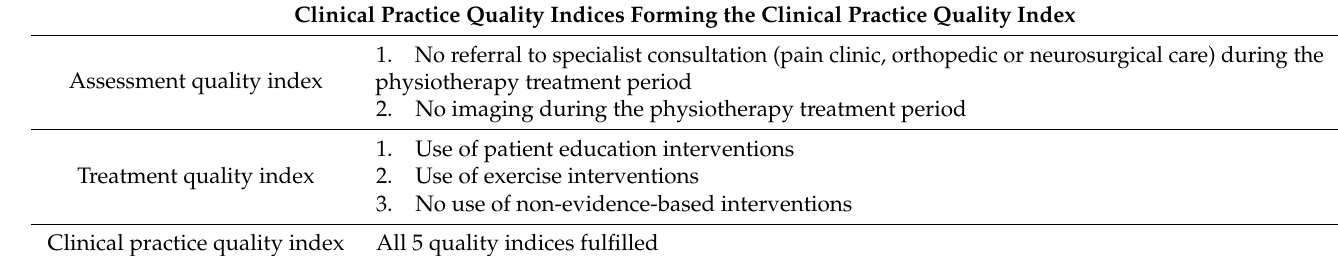
Table 1. Clinical practice quality index for PTs’ care delivery to patients with LBP. Clinical Practice Quality Indices Forming the Clinical Practice Quality